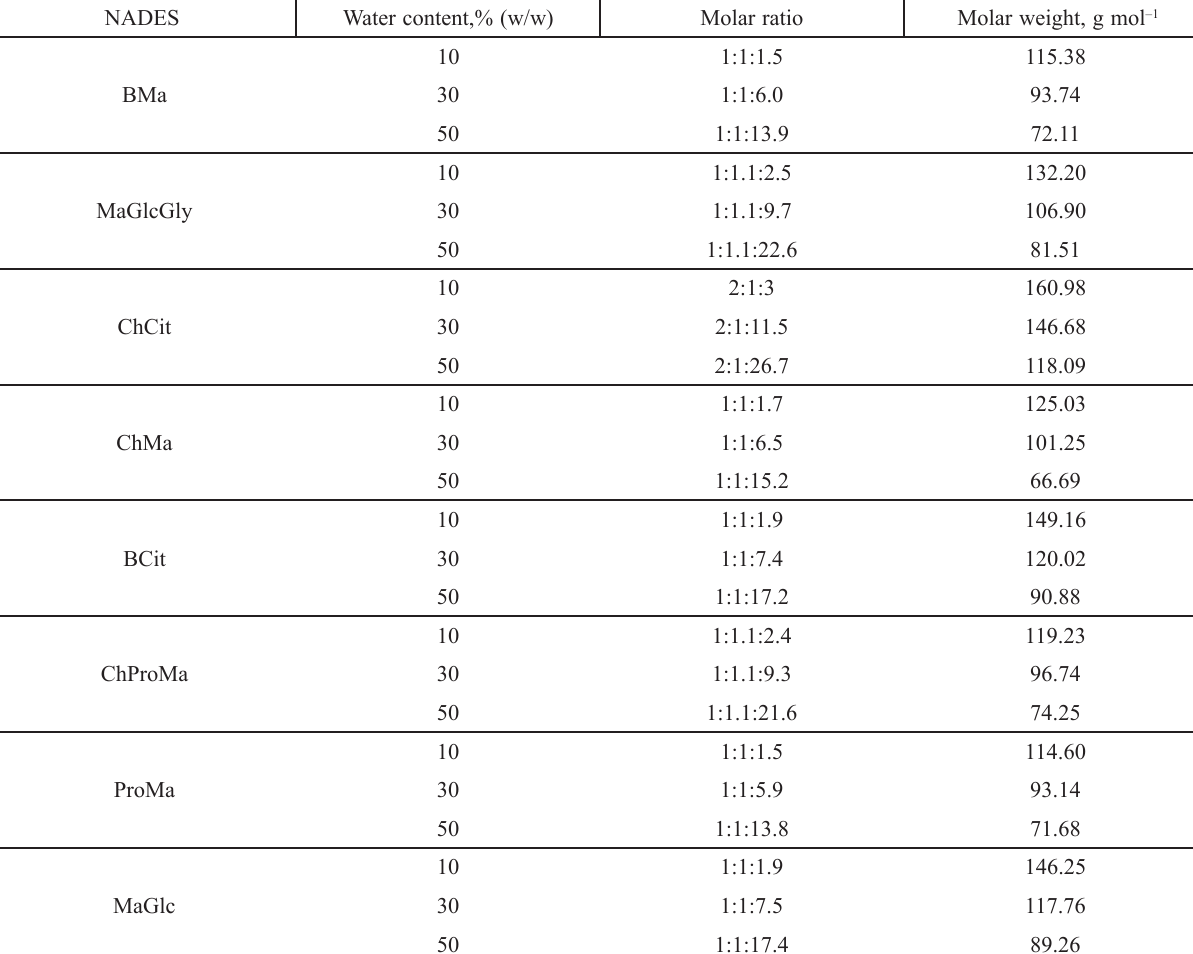
Table 1 S – Used NADES and their molar ratios and molar mass